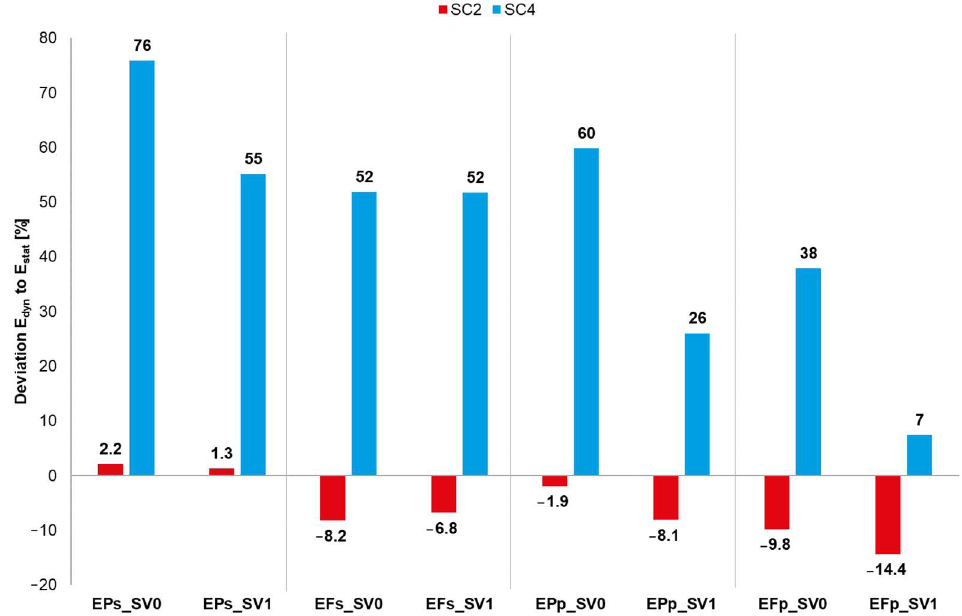
Figure 9. Deviation between the static and dynamic approach for SC2 (red) and SC4 (blue) for all control strategies in comparison with a 2-day storage capacity (_SV1) (own representation).